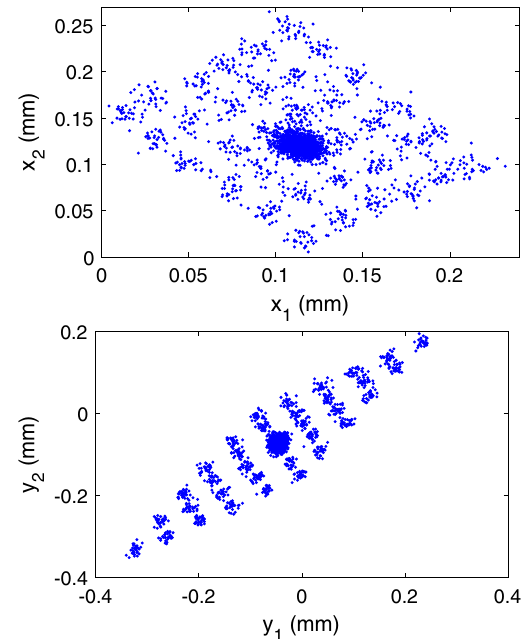
FIG. 5. Trajectory scan data on two BPMs in L3 with a separation of 24.7 m. Top: horizontal. Bottom: